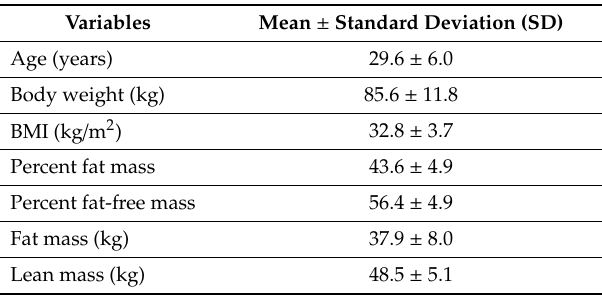
Table 1. Subject characteristics ( n = 30).